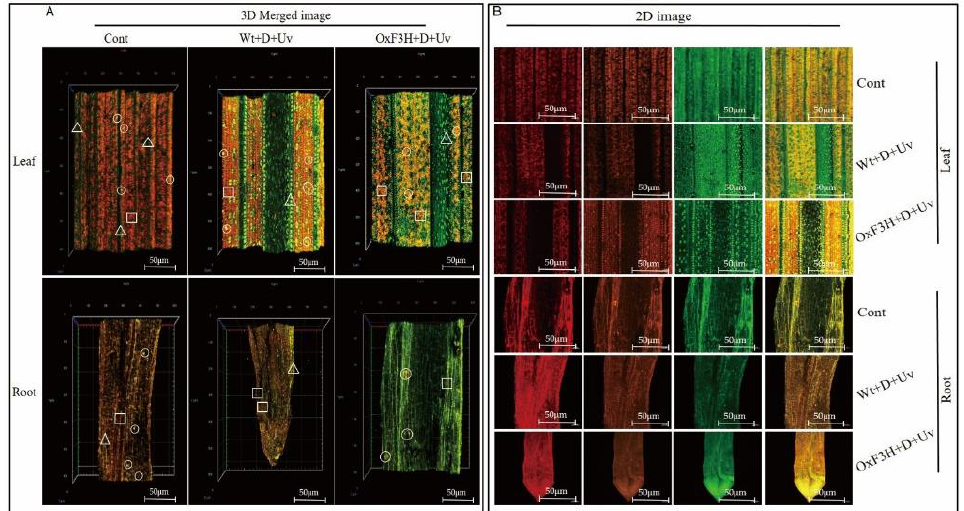
Figure 5. Detection of flavonoids in leaf and root under drought and UV-B radiation combined stress. Naringenin, kaempferol, and quercetin were visualized in rice plant tissue via DAPB staining using a confocal laser scanning microscope (CLSM). Box ( A ) shows a 3D image of naringenin, kaempferol, and quercetin merged in a single image. The upper images in box A are leaf images, and the lower are root images. Naringenin, kaempferol, and quercetin were detected in all the leaves and roots with different intensities. Red color shows naringenin, orange shows quercetin, and green shows kaempferol, indicated by □, Ο , and Δ , respectively. Box ( B ) shows 2D images of single and merged flavonoids. The upper three rows of images show leaves, and the lower three rows show root images.